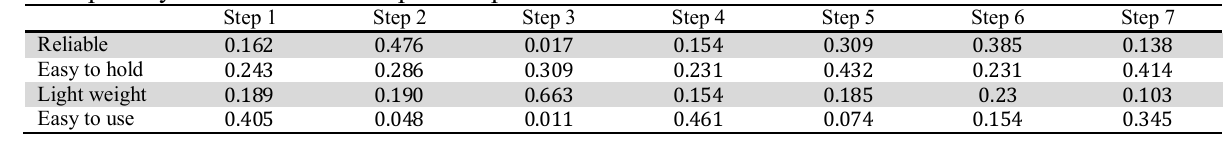
The priority of CNs in seven steps of improvement